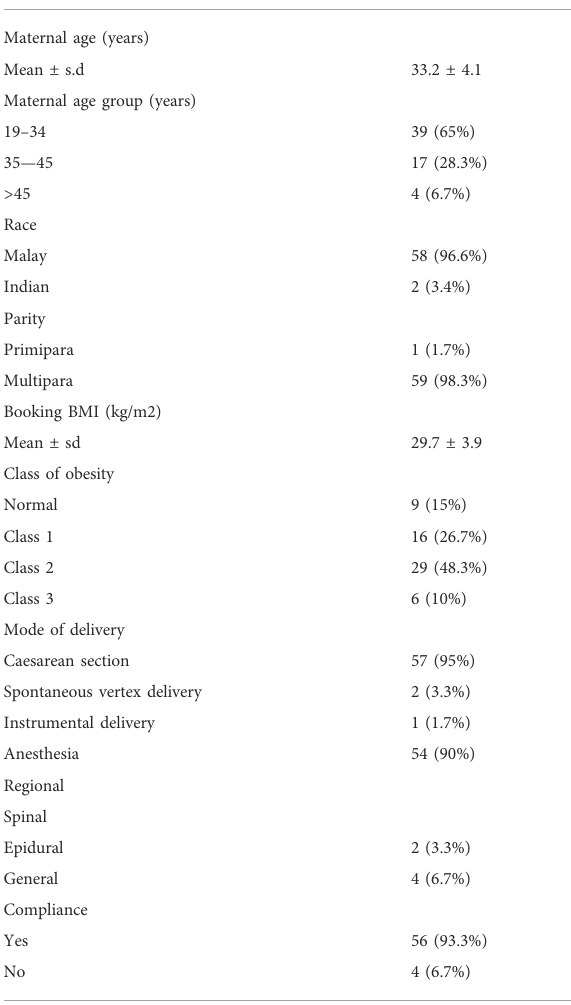
TABLE 1 Baseline characteristic of